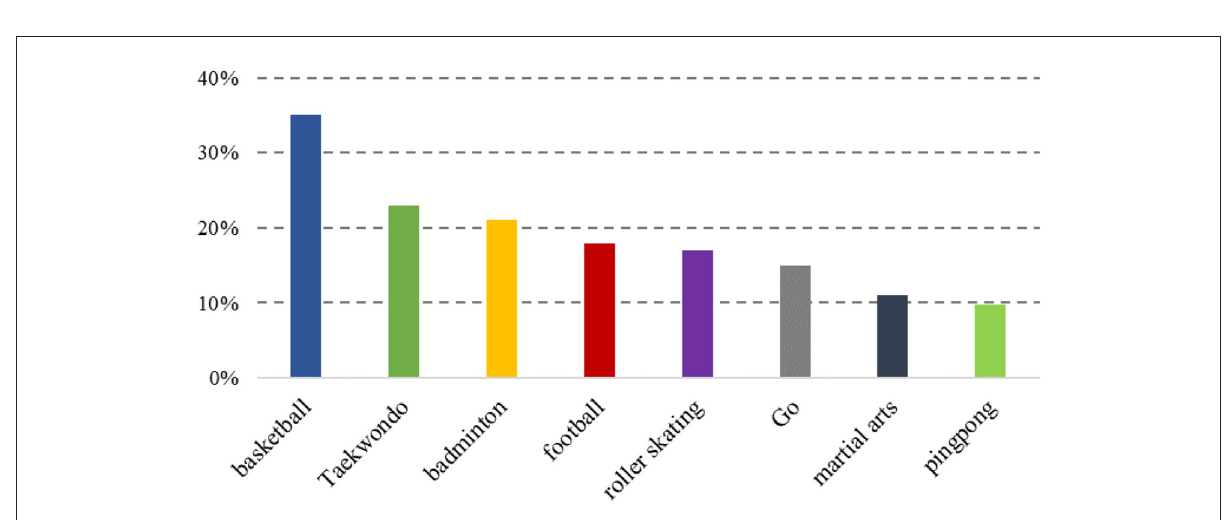
FIGURE4 Selection of intended sports